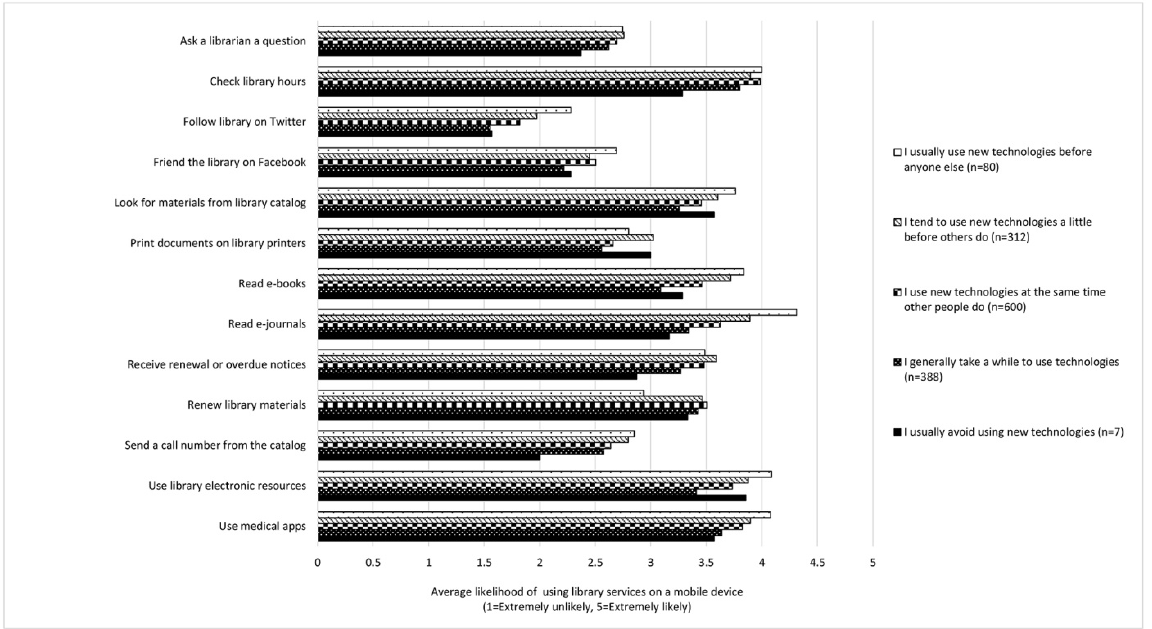
Figure 5 Likelihood of using library services on a mobile device by technology